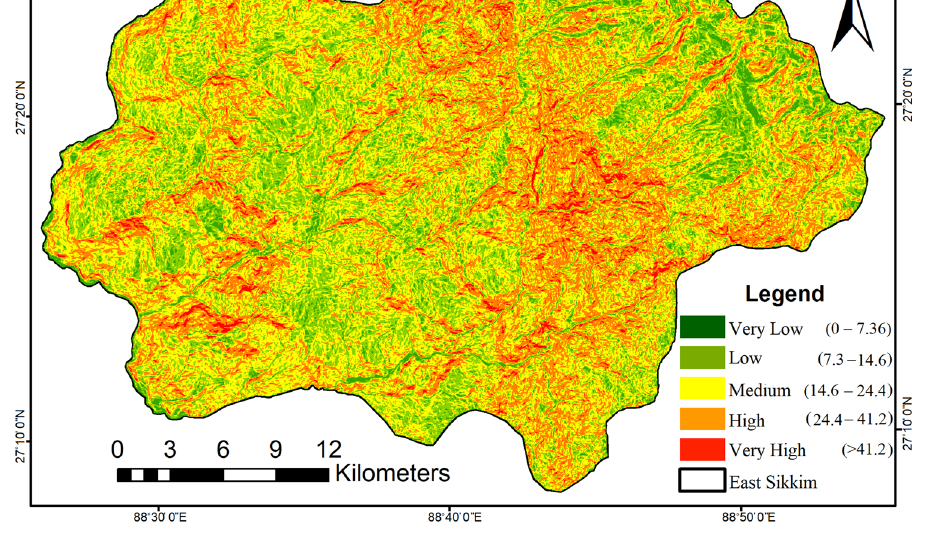
Fig. 7 Slope map of East Sik- kim